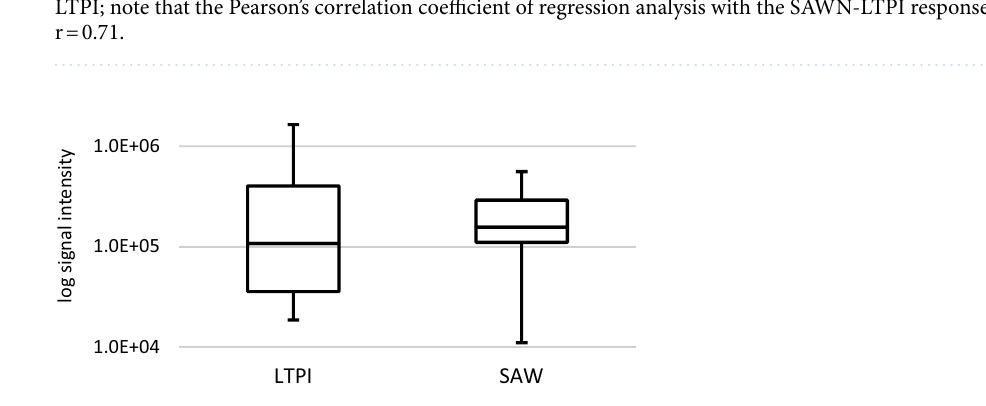
Figure 1. Boxplots of the log-transformed mean signal intensities over all substituted anilines (1 mM) analyzed with LTPI after either desorption from a paper target (“LTPI”, on the left) or coupled to SAWN (“SAW”, on the